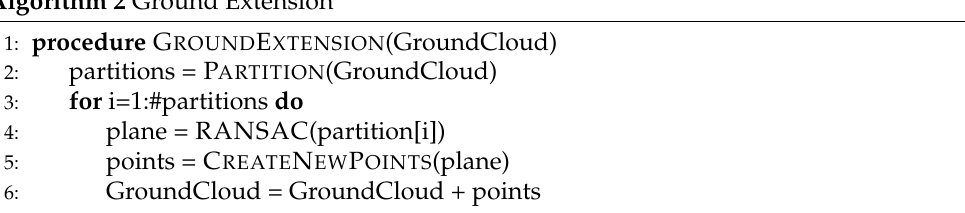
Algorithm 2 Ground Extension